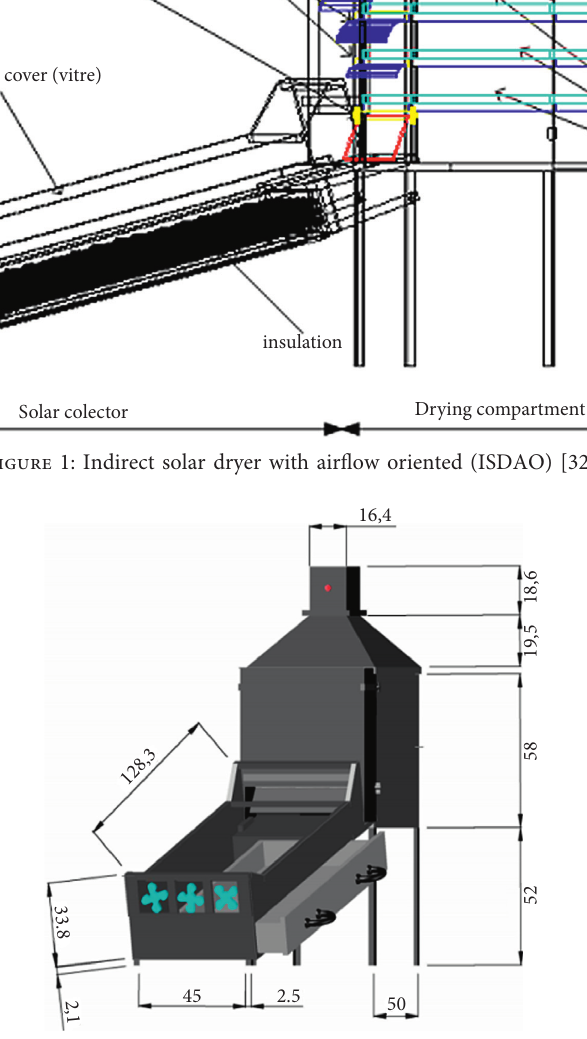
Figure 2: Design of the indirect solar